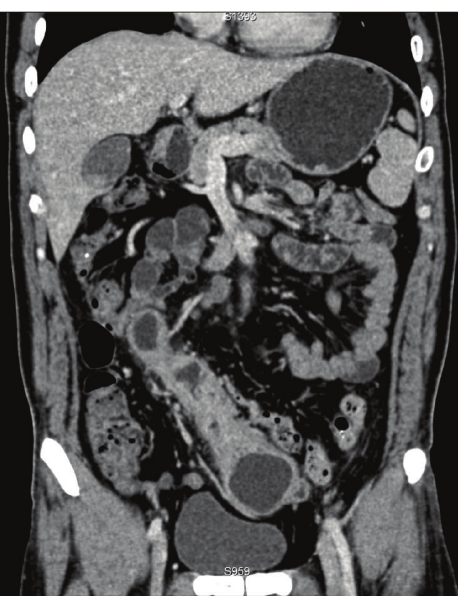
Figure 3: Coronal reconstruction image shows decreased cyst with enhanced wall and absorption of inflammation around it.